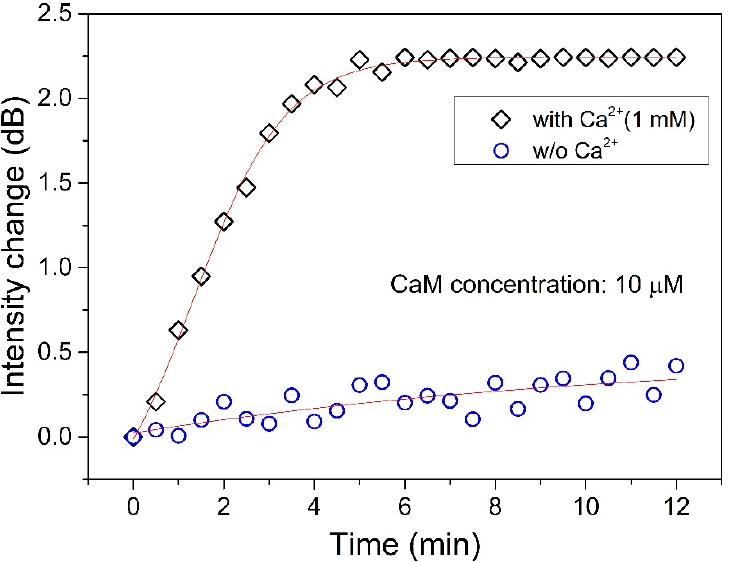
Figure 7. Interaction monitoring between CaM (10 µM) and TRP channels in solutions with a Ca 2+ concentration of 1 mM (labeled “ ◇ ”) and without Ca 2+ (labeled “ ○ ”).